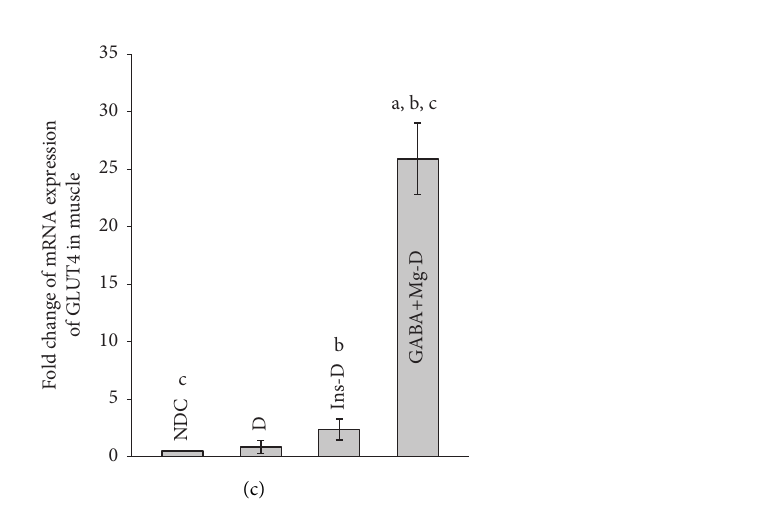
Figure 5: Comparison of fold change in PEPKC mRNA expression. (a) G6pase, (b) mRNA expression of GLUT4, (c) the nondiabetic control group (NDC) was fed with a normal diet, the chronic diabetic group received high-fat diet and 35mg/Kg STZ (D), diabetic animals treated with insulin (2.5 U/Kg two times per day) (Ins-D), and diabetic animals treated with GABA (1.5gr/kg)+MgSO 4 (10g/l add in drinking water) (GABA +Mg-D) (10 rats in each group. Data are expressed as mean ± SEM). (a) Significant difference between D and other groups ( P < 0.01). (b) Significant difference between GABA+Mg-D and Ins-D group ( P < 0.01). (c) Significant difference between NDC group and GABA+Mg-D ( P < 0.01).